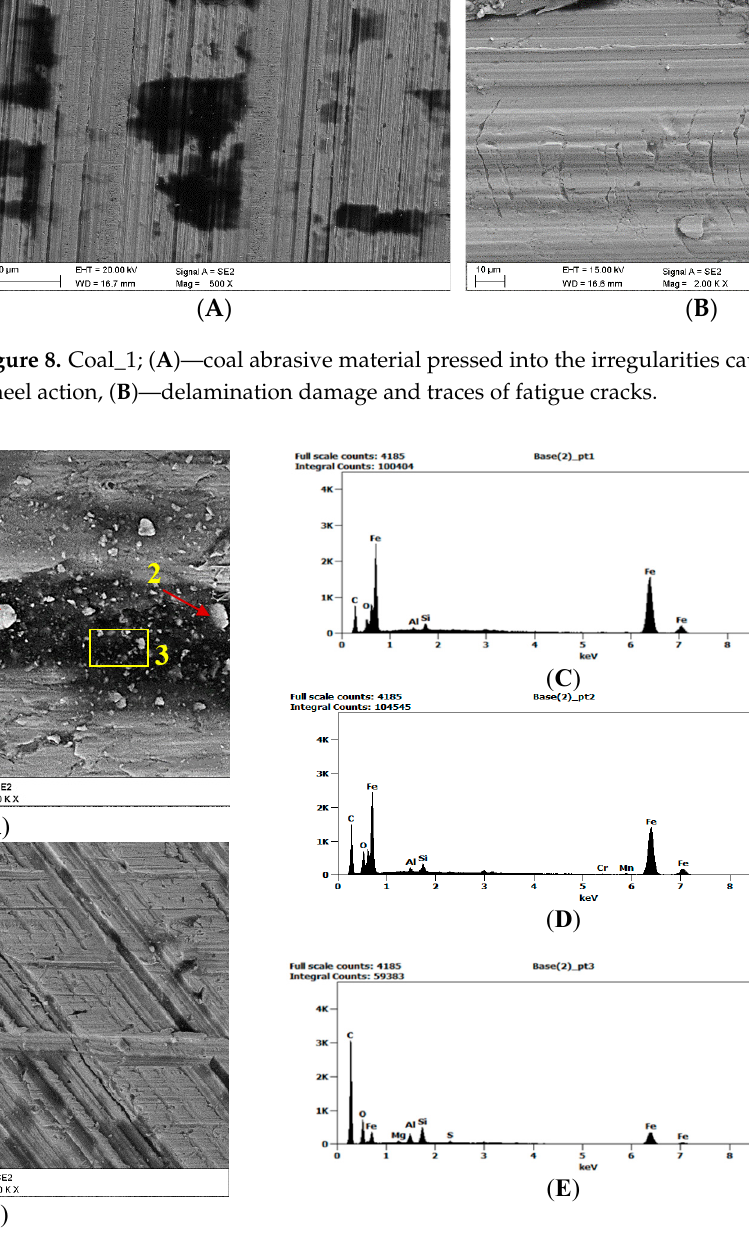
Figure 9. Image of the surface of the steel samples worn in the presence of the Coal_2 abrasive; ( A )—abrasive coal film on the steel sample surface along with the inactivated wear products, ( B )—microscratches against the background of grinding traces and coal films, ( C – E )—EDS spec- tra determined at points 1, 2, and in area